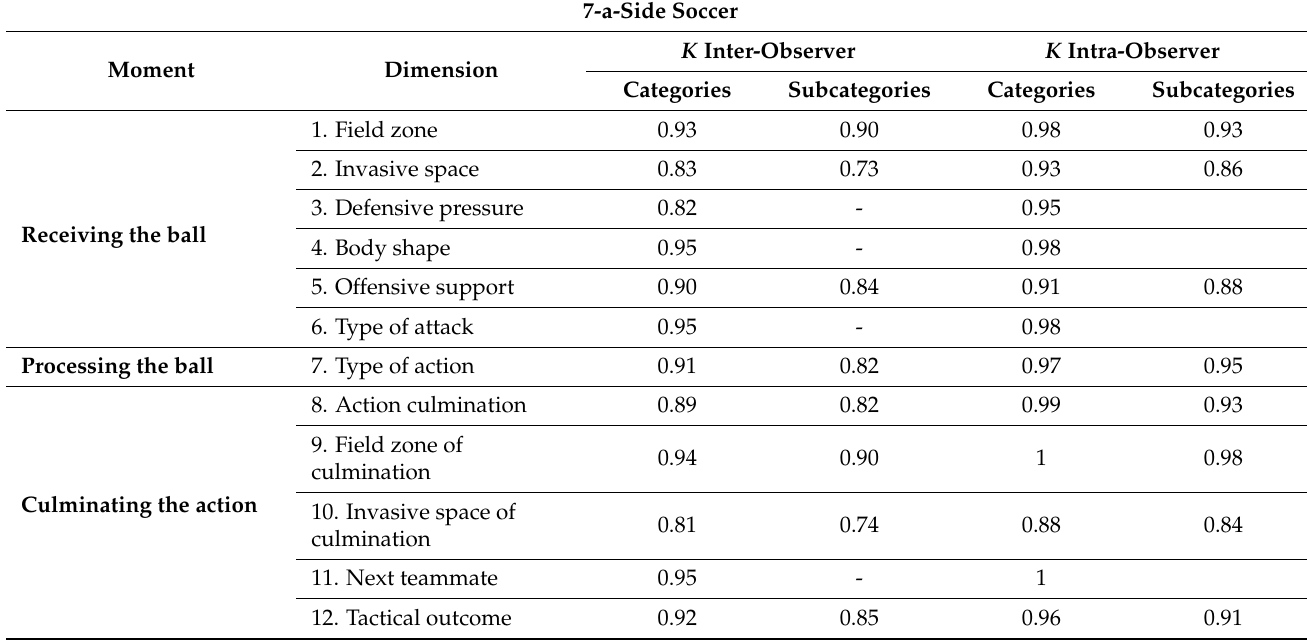
Table 6. Kappa values obtained for the dimensions of the INDISOC observational tool in 7-a-side and 11-a-side